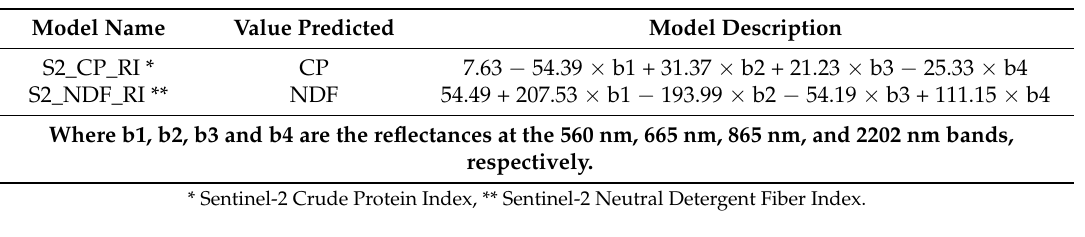
Table 2. Prediction models for CP and NDF, using the reflectance-based method.